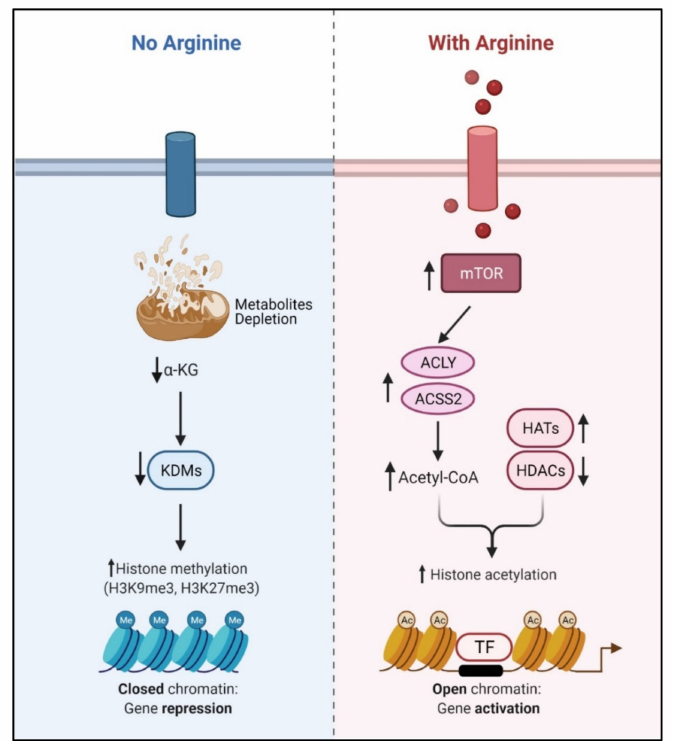
Figure 4. Arginine acts as an epigenetic regulator. In the presence of arginine, mTOR induces the ACLY and ACSS2 to increase the level of acetyl-CoA, which is the main resource of histone acetyl-transferases (HATs). Increased histone acetylation induces the chromatin-remodeling and gene activation. Conversely, arginine deprivation causes metabolites depletion, including alpha- ketoglutarate ( α -KG), which down-regulates lysine-demethylases (KDMs) and induces globe repres- sive histone